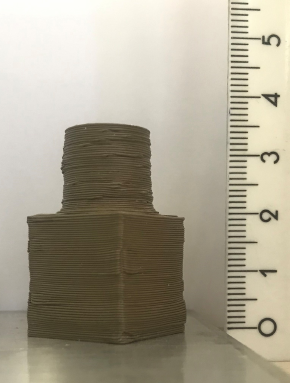
Figure 2. As built part before milling.